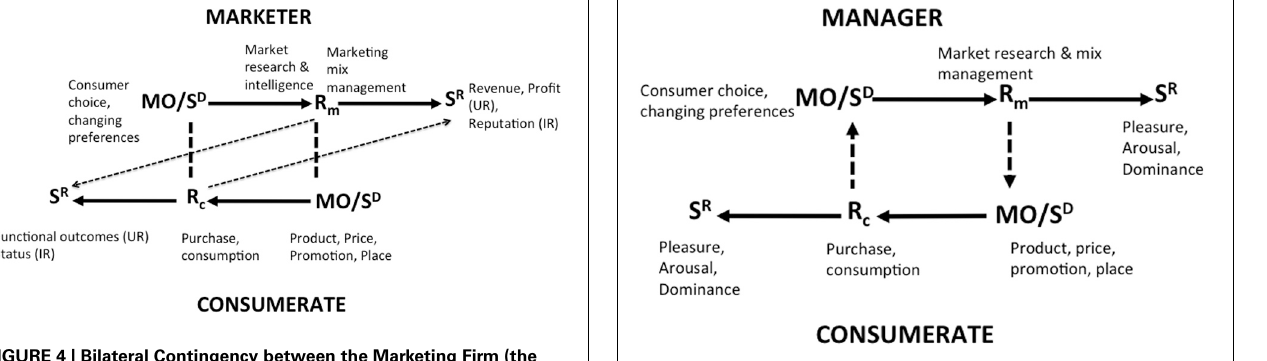
marketing firm and the firm’s consumerate in terms of emotional response.